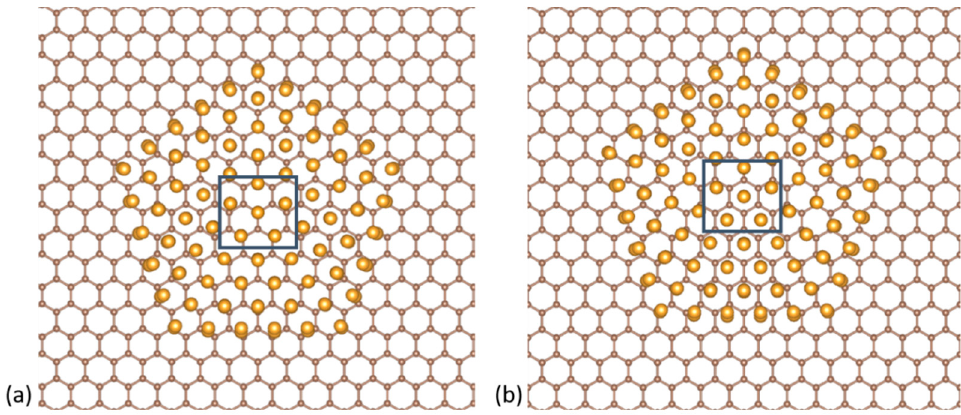
Figure 5. Top-down views of the two different positionings for a decahedral NP on graphene with ( a ) the vertex on top of a C atom and ( b ) on the center of the hexagon formed by the C atoms.